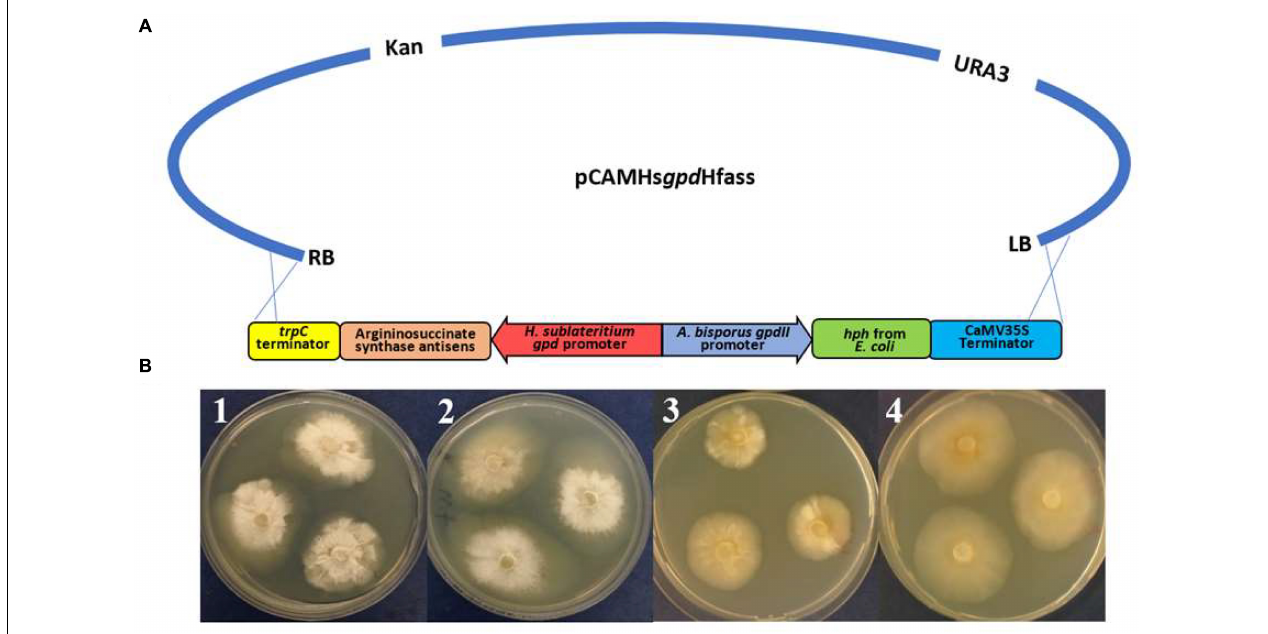
FIGURE 7 | (A) Schematic representing the antisense vector pCAMHs gpd Hfas used for targeting argininosuccinate synthetase in Hypholoma fasciculare . (B) H. fasciculare wild type and antisense transformant 14 showing differences in the colony growth rate on potato dextrose agar (PDA) with and without arginine supplementation. 1 = H. fasciculare wild type on PDA medium; 2 = H. fasciculare wild type on PDA medium supplemented with 5 mM of arginine; 3 = H. fasciculare antisense transformant 49 on PDA medium; 4 = H. fasciculare antisense transformant 49 on PDA medium supplemented with 5 mM of arginine.